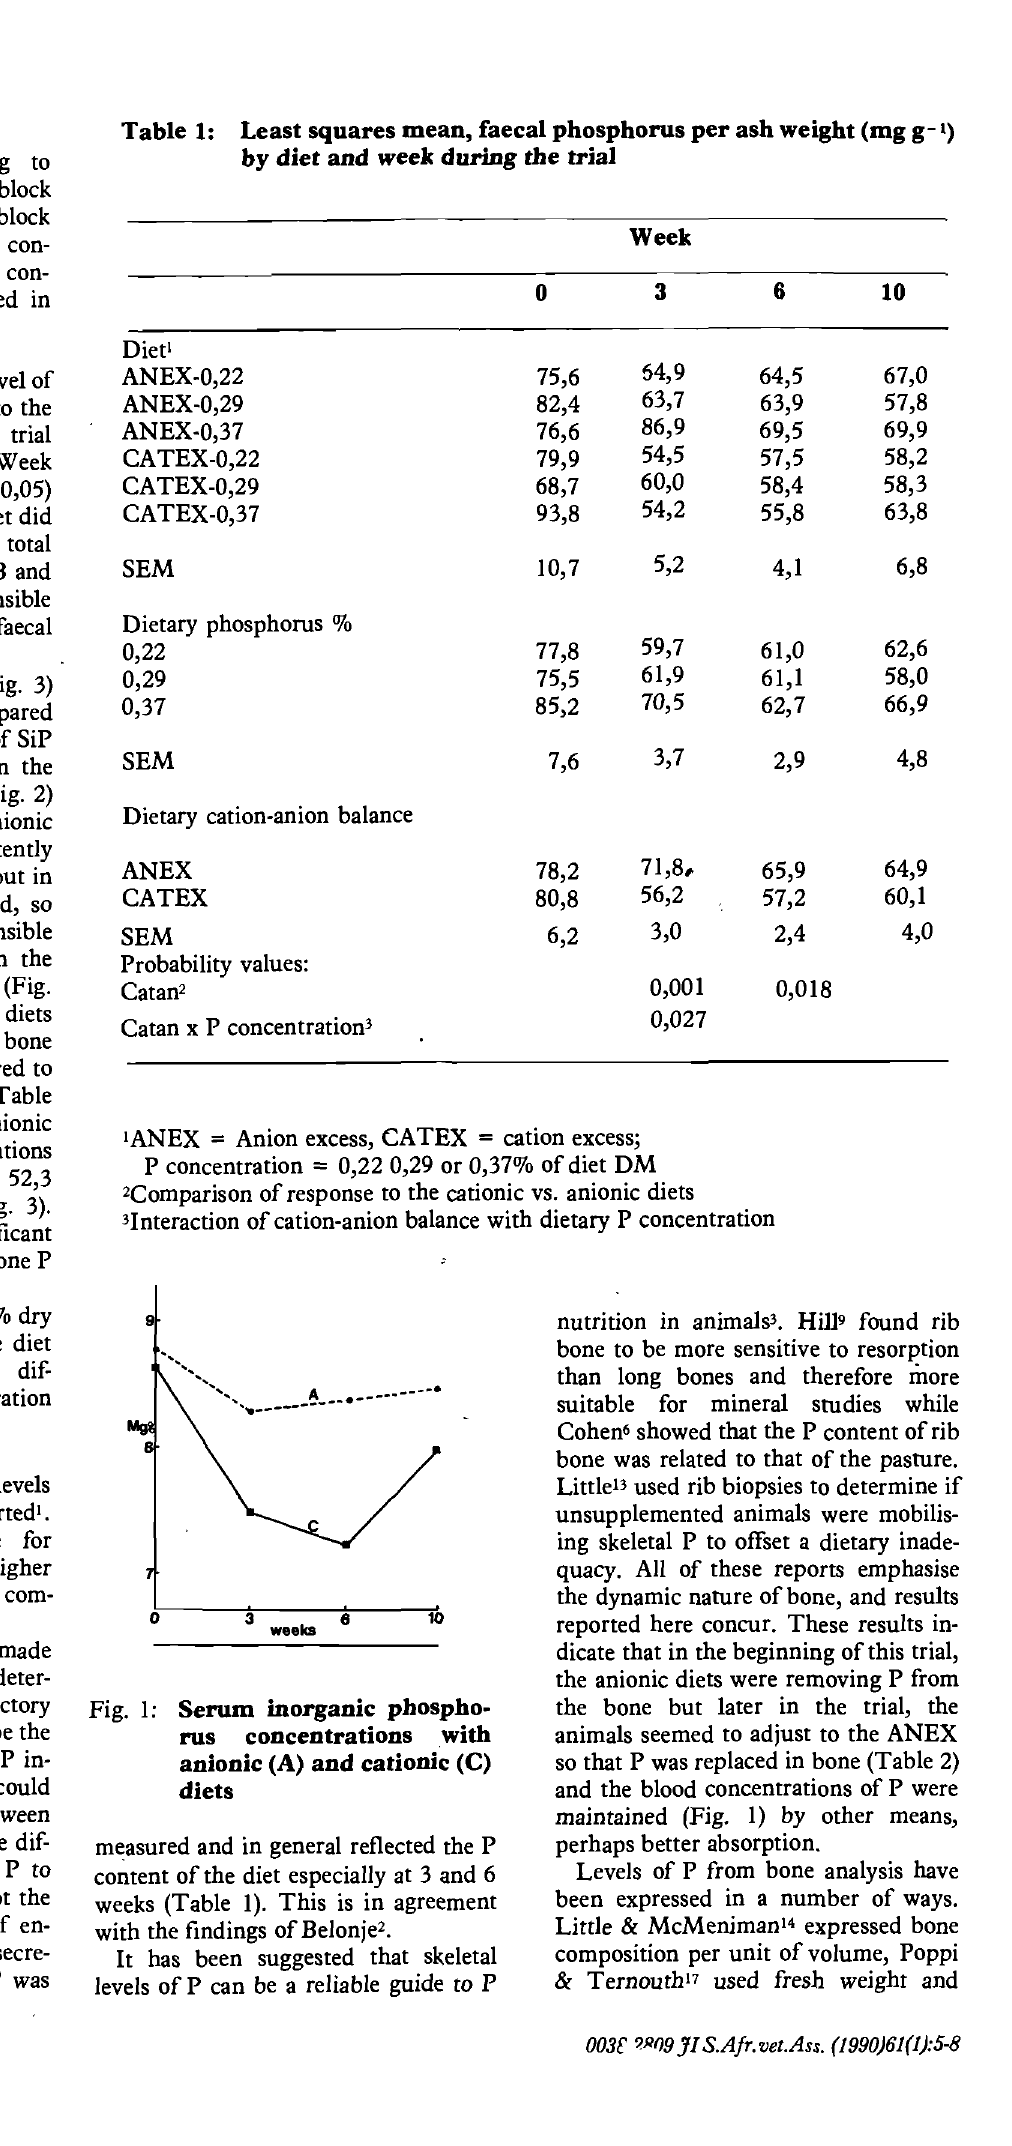
Fig. 1: Serum inorganic phospho rus concentrations with anionic (A) and cationic (C) diets measured and in general reflected the P content of the diet especially at 3 and